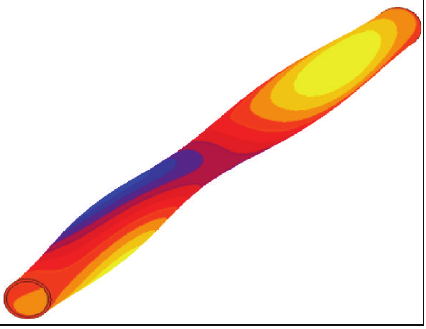
Figure 7: Deformed shape for shell with longitudinal weld.